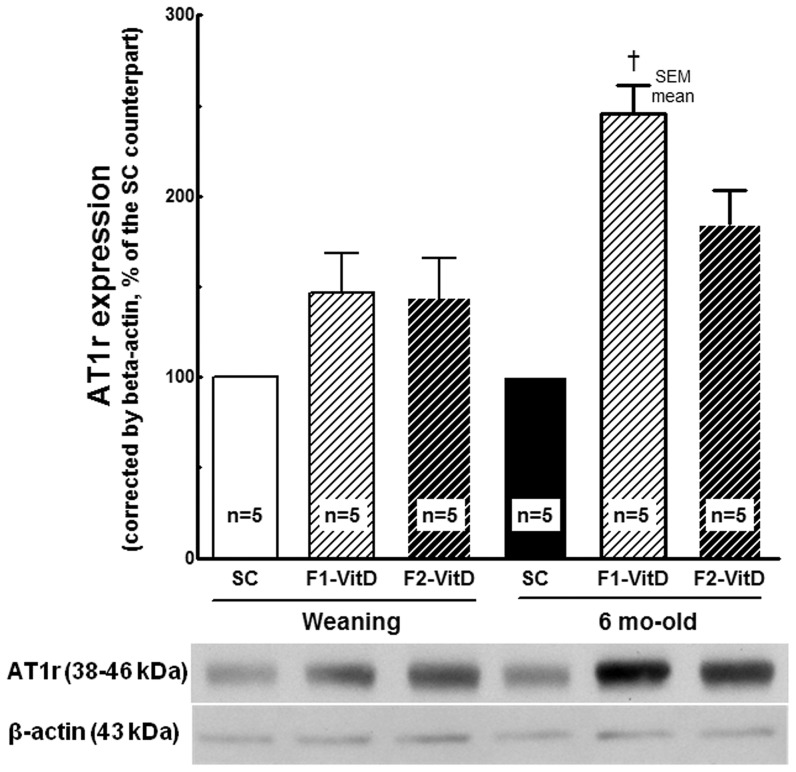
Western blotting analysis of renal tissue at weaning and 6 months of age for AT1 receptor expression.The average values were measured and equal protein loading was confirmed by probing blots with beta-actin antibody and is expressed as a percentage of the SC counterpart. Data are reported as means ± SEM; P<0.05, one-way ANOVA and post-hoc of Tukey's test: † compared to SC counterpart; ‡ compared to F1 generation.